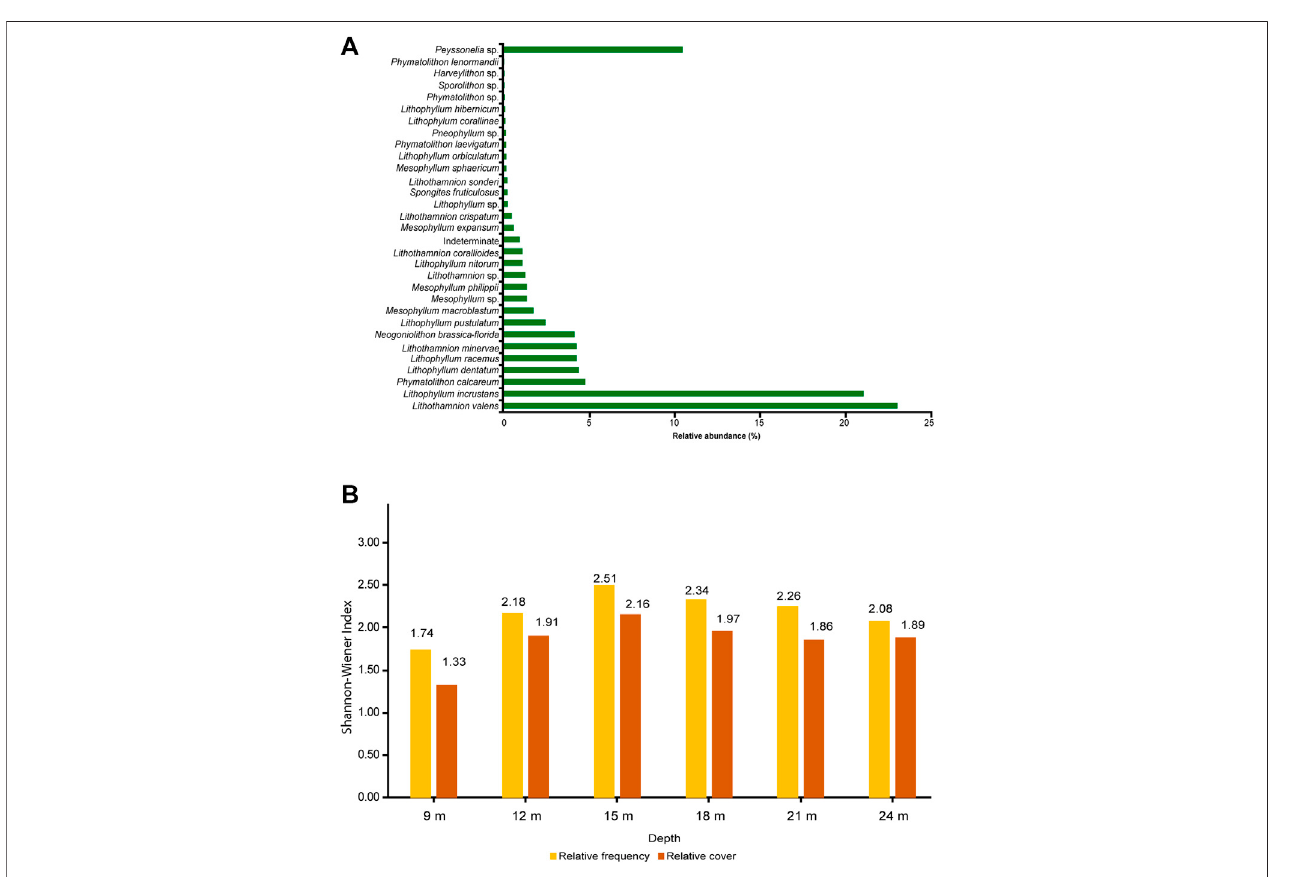
FIGURE 8 | (A) Relative abundance of the identi fi ed taxa at the sampling depths. (B) Shannon-Wiener index diversity measures (based on species frequency or cover) at the sampling depths.